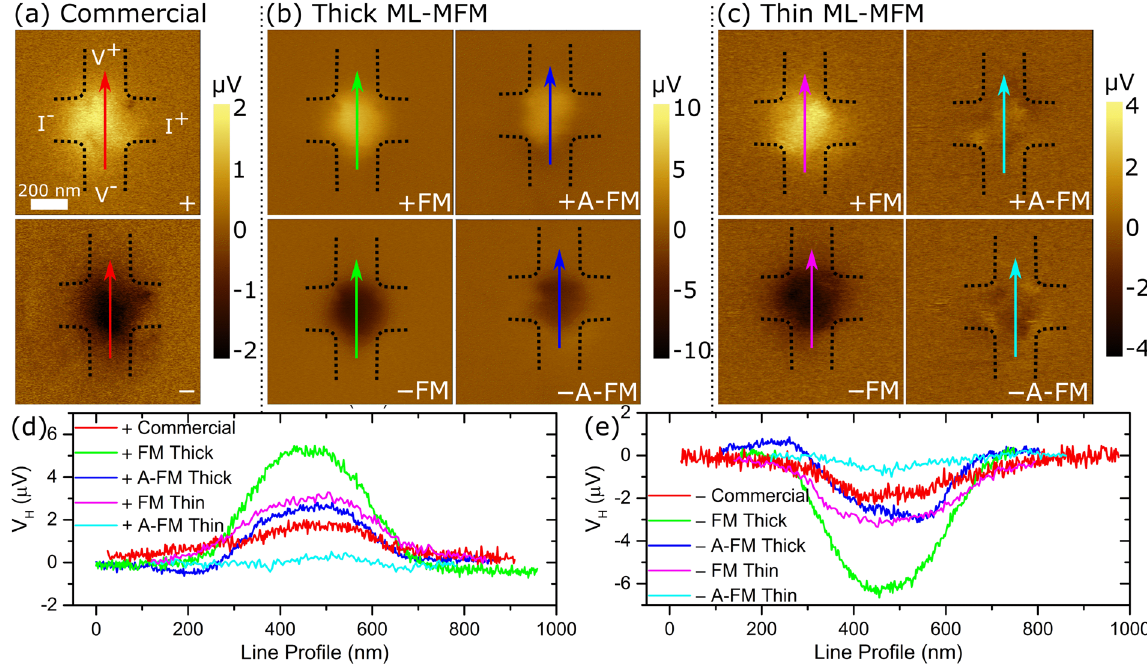
Figure 6. Experimental mSGM maps of local Hall voltage. Magnetic SGM images for ( a ) commercial Nanosensors ™ MFM probe, ( b ) thick and ( c ) thin ML-MFM probes in the FM ( ↓↓ ) and A-FM states ( ↓↑ ). Top/ bottom rows of images in ( a ), ( b ) and ( c ) are for probes magnetised + / − , respectively. Black dashed lines depict the Hall cross borders. The electrical connections shown in ( a ) are the same for all other images. ( d ) and ( e ) are line profiles of the Hall voltage across the lines of the same colour indicated in ( a – c ) for the probes magnetised in + and − direction, respectively.